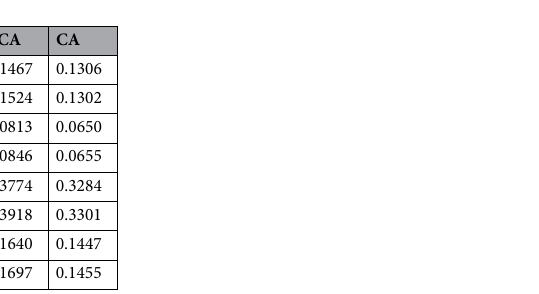
Figure 3. Spatial distribution of the mean multi-model ensemble (CMIP5 ALL and NAT simulations) Gini- coefficients for the ( a ) PRCPTOT, ( b ) SDII, ( c ) R95p and ( d ) RX5day in CA from 1961 to 2005. The subfigures were done in the software R 4.0.2 (https:// cran.r- proje ct. org/ bin/ windo ws/), and then the subfigures were merged by using the Microsoft PowerPoint 2013 software (https:// www. micro soft. com/).